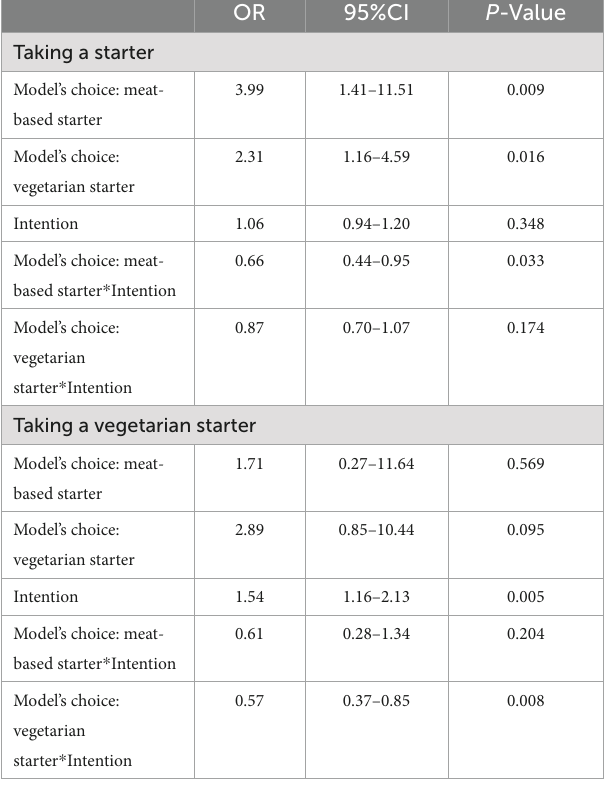
TABLE 3 Modeling of the starter choice and interaction with vegetarian intentions. OR 95%CI P -Value